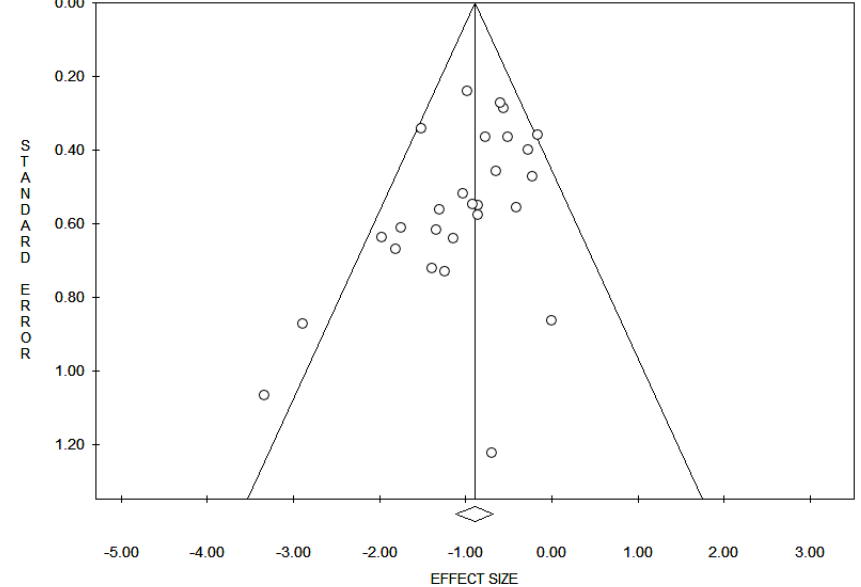
Figure 2. Funnel plot for evaluation of bias across studies. The x -axis in the present analysis represents all the markers expression and the y -axis represents the standard error. In the absence of bias, a funnel plot should be a symmetrical inverted funnel. In the presence of bias, smaller studies with no expression would be missing, thus creating an asymmetrical funnel. Asymmetry in a funnel plot suggests that there is a systematic difference between larger and smaller studies and/or that there is publication bias.